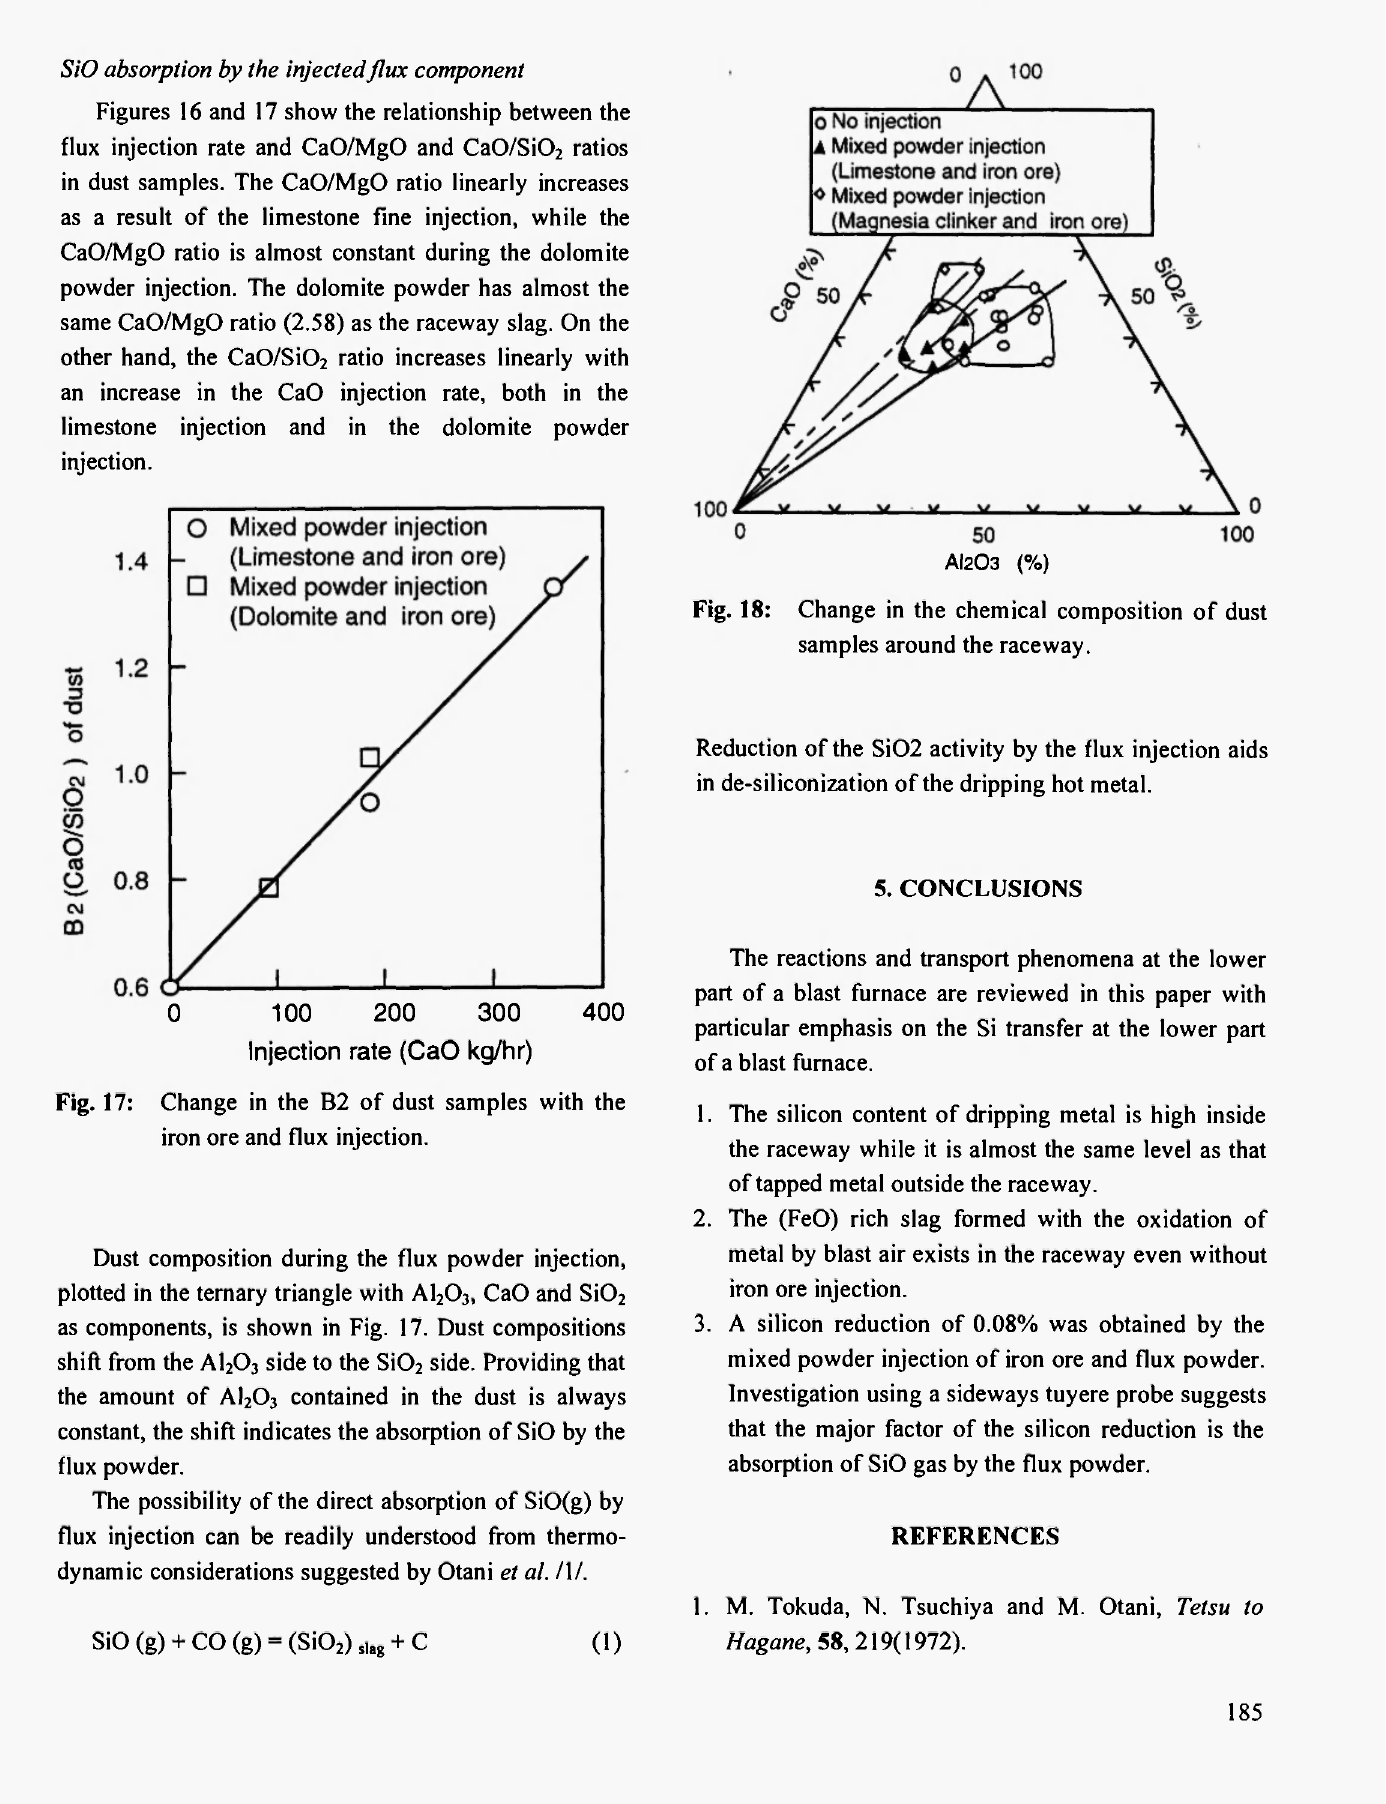
Dust composition during the flux powder injection, plotted in the ternary triangle with A1 2 0 3 , CaO and Si0 2 as components, is shown in Fig. 17. Dust compositions shift from the A1 2 0 3 side to the Si0 2 side. Providing that the amount of A1 2 0 3 contained in the dust is always constant, the shift indicates the absorption of SiO by the flux powder.